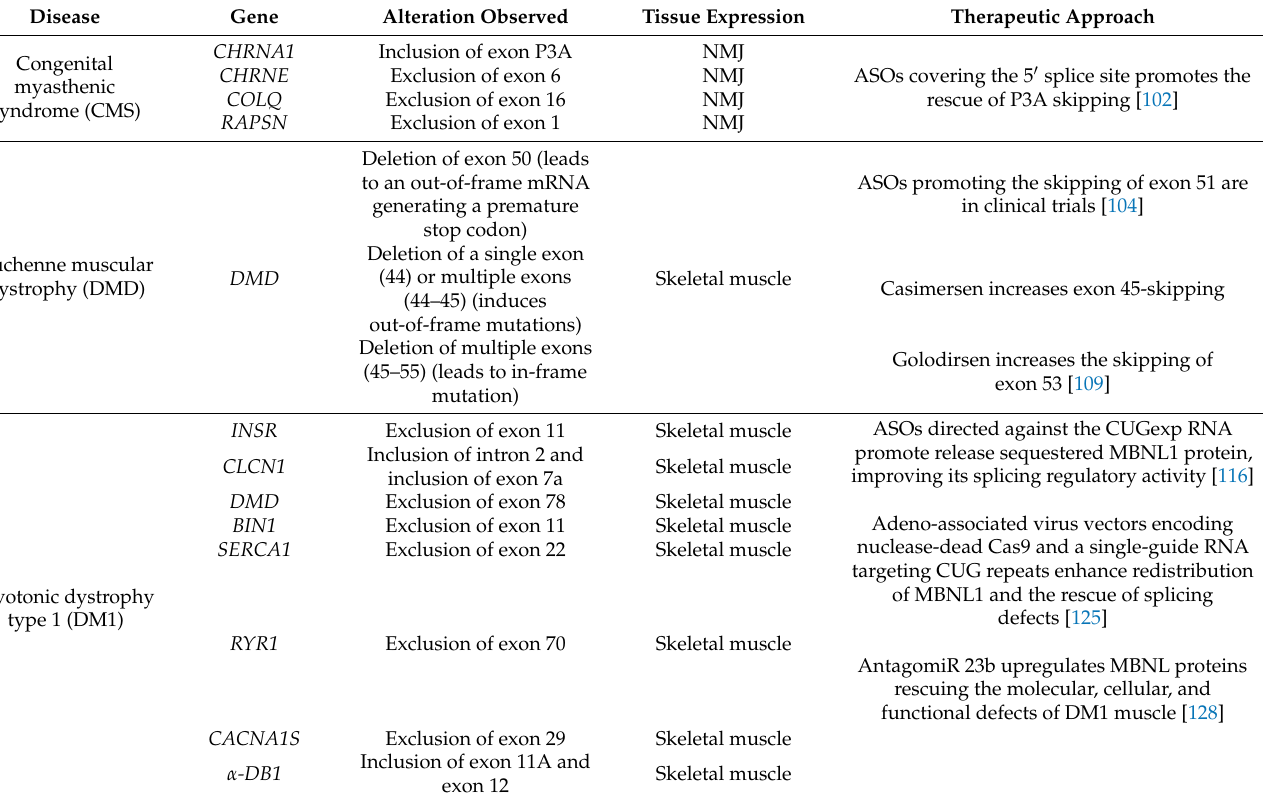
Table 2. Summary of the therapeutic approaches targeting alterations associated with NM-diseases. Disease Gene Alteration Observed Tissue Expression Therapeutic